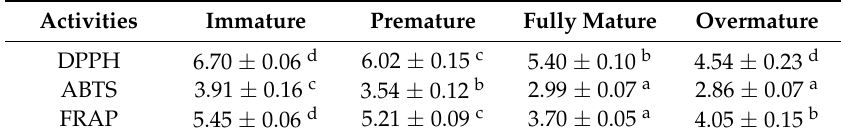
Different superscripts in the same row indicate significant differences ( p <